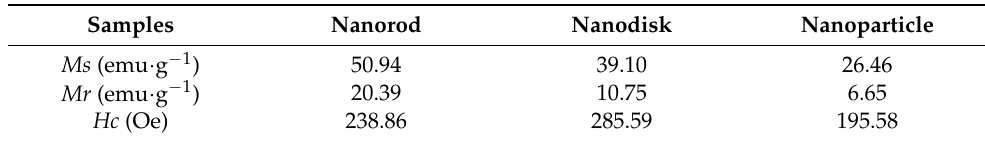
Figure 7. Magnetization curves of the three C@Fe 3 O 4 composites at 300 K. The inset shows a zoom of the low magnetic field from − 2000 to 2000 Oe. Table 1. The magnetic data obtained from the magnetic hysteresis loops of the obtained C@Fe 3 O 4 composites.